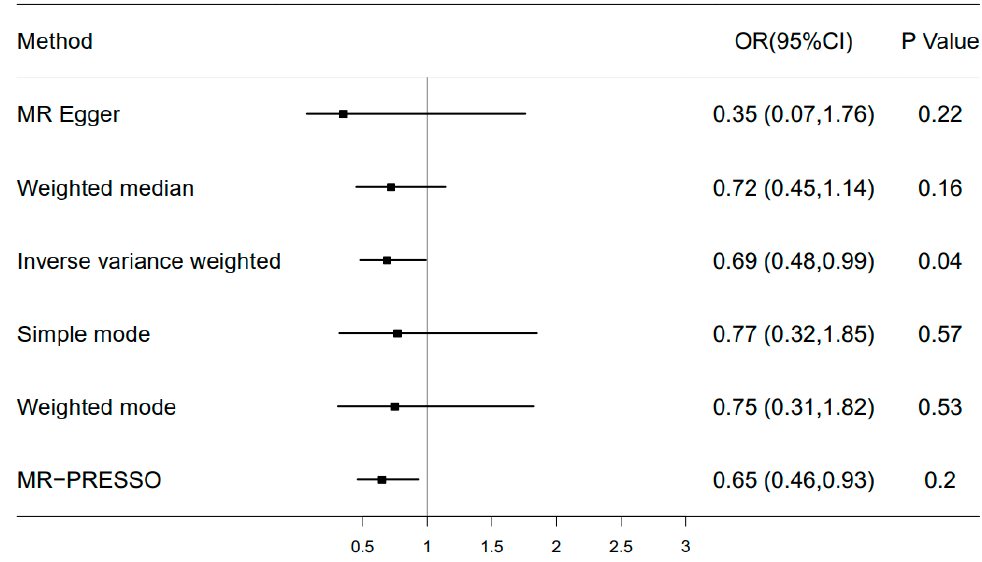
Figure 6. Forest plot of Mendelian randomization for the relationship between sleep duration and hip fracture risk. The random effects inverse-variance weighted (IVW) method was utilized in the main MR analyses. MR-Egger regression, the weighted median, simple mode, and weighted mode were performed as complementary analyses.